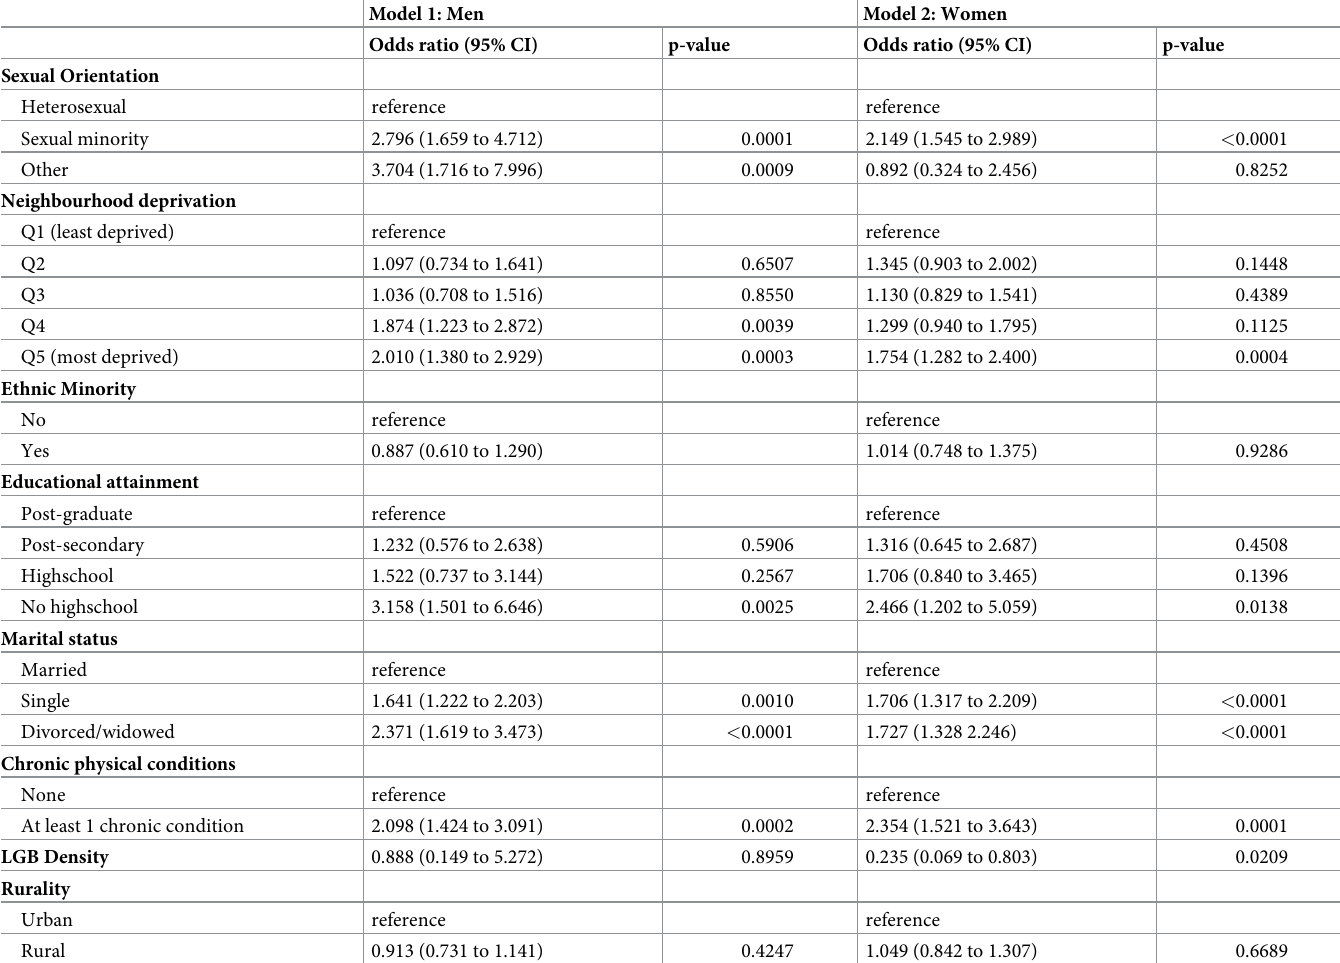
Table 3. Hazard odds ratio for the risk of SRB across sexual orientation and neighbourhood deprivation among Ontarians aged 18+ from 2007–2017, stratified by sex (unweighted n = 169,090; weighted n = 8,778,120